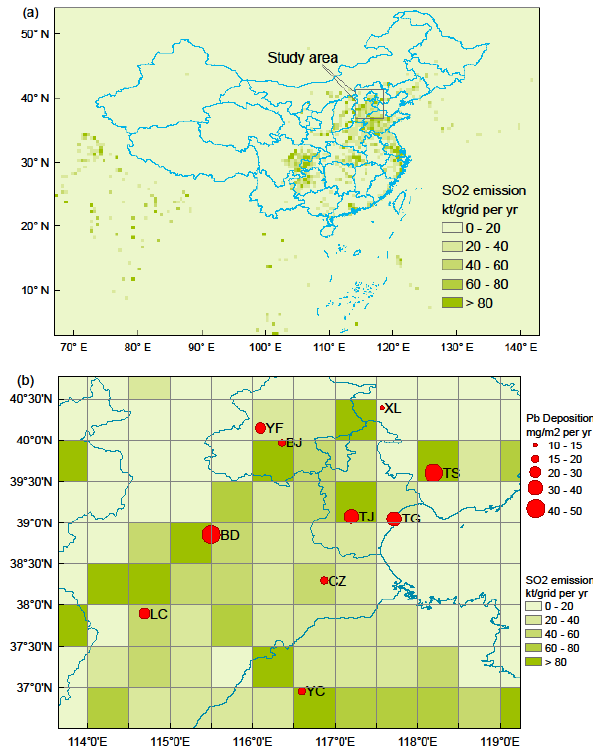
Figure 1. Locations of the study area (a) and sampling sites (b) in Northern China with lead deposition and SO 2 emission distribu- tions. The total lead deposition data are means of 3-year observa- tions from December 2007 to November 2010. The emission data for SO 2 are from 2006 (Zhang et al., 2009) and have a resolution of 0.5 ◦ × 0.5 ◦ . In Northern China, the annual SO 2 emission unit of kt grid − 1 is approximately 400mgm − 2